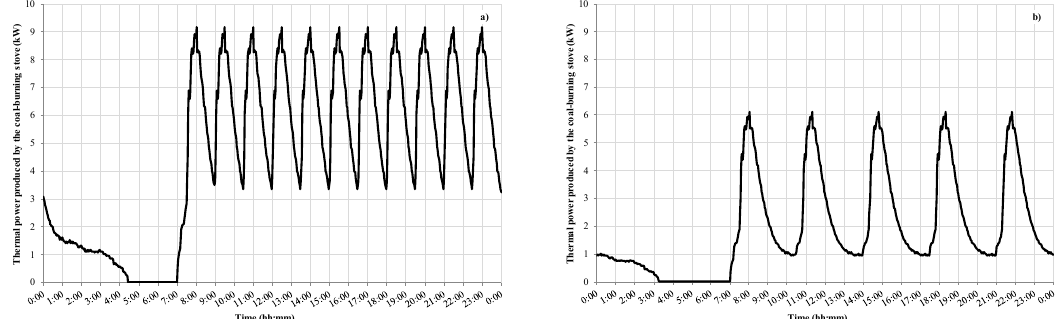
Figure 9. Daily thermal power produced by the stove for ( a ) the conventional heating system CS1 and ( b ) the conventional heating system CS2.